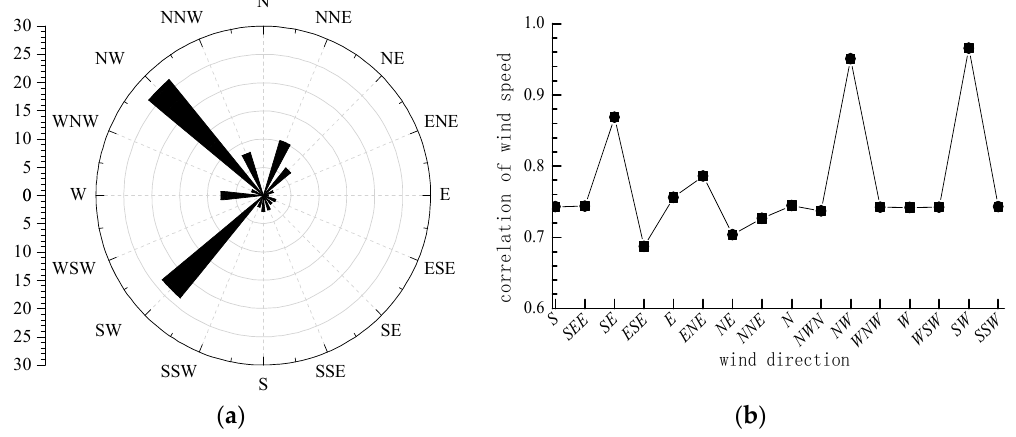
Figure 9. Statistical curve of WSC coefficient under different wind directions zone; ( a ) Wind rose; ( b ) Statistical curve of WSC coefficient under different wind directions zones.